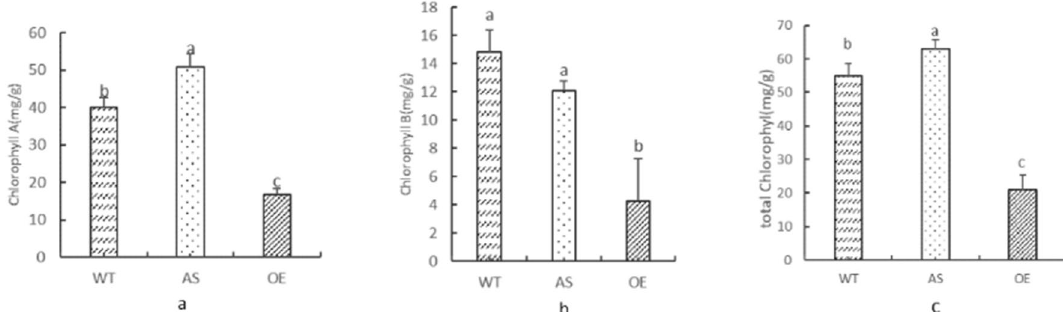
Figure 3. The content of Chlorophyll A, Chlorophyll B, total Chlorophyll content in different materials. ( a ) The content of Chlorophyll A; ( b ) the content of Chlorophyll B; ( c ) the content of total chlorophyll. Different